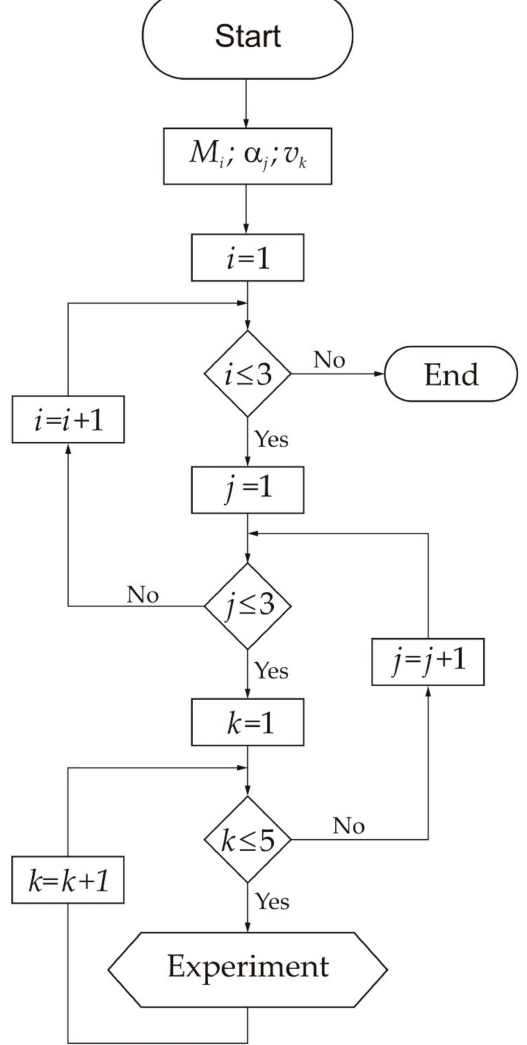
Figure 3. Algorithm for separating the seed mixture in a pneumatic conical separator: i , j , k —values of variable parameters ( M , α , v